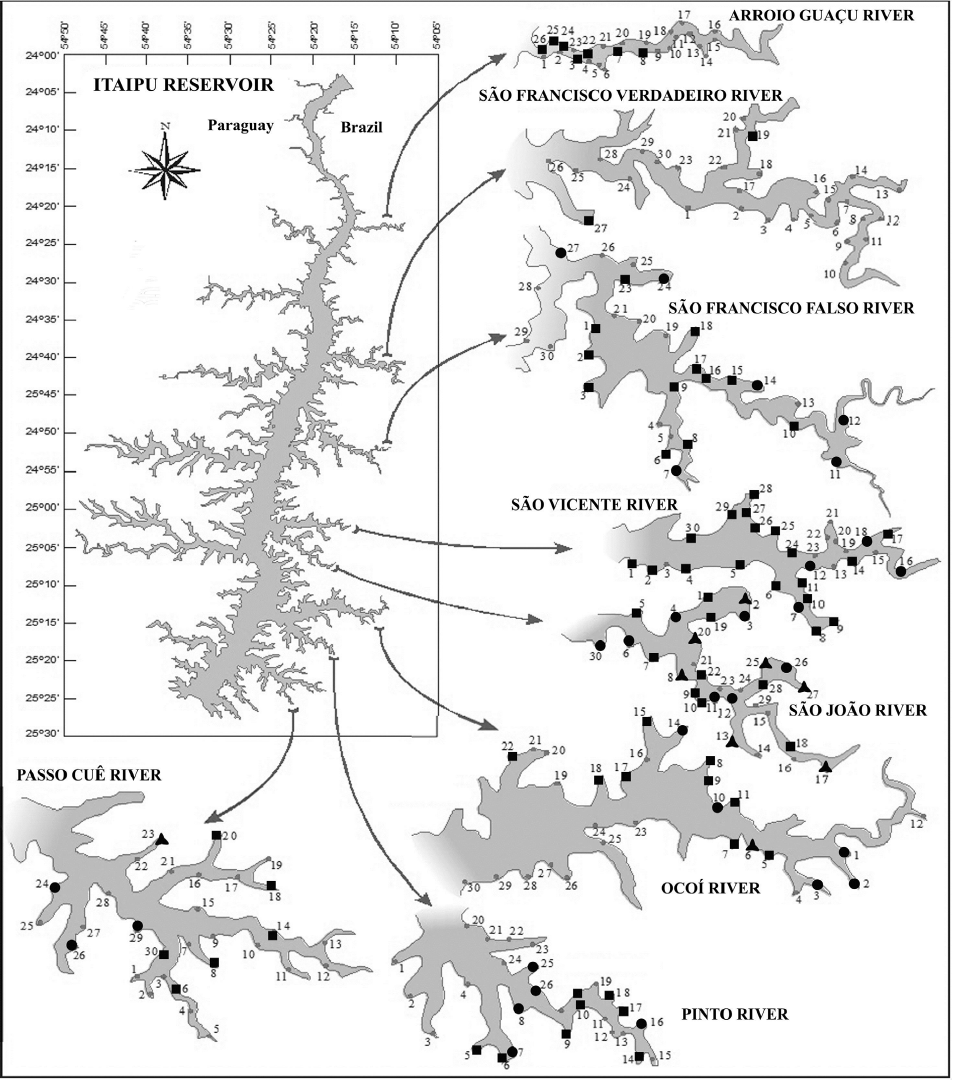
Figure 1. Map of the Itaipu reservoir indicating the sampling points and presence of Chara sp., Nitella sp. or both. Nitella ; Chara ; Where: “Co-occurrence”. Numbers in the tributaries indicate the sampling sites. Modified ◼ ● ▴ from Thomaz et al.